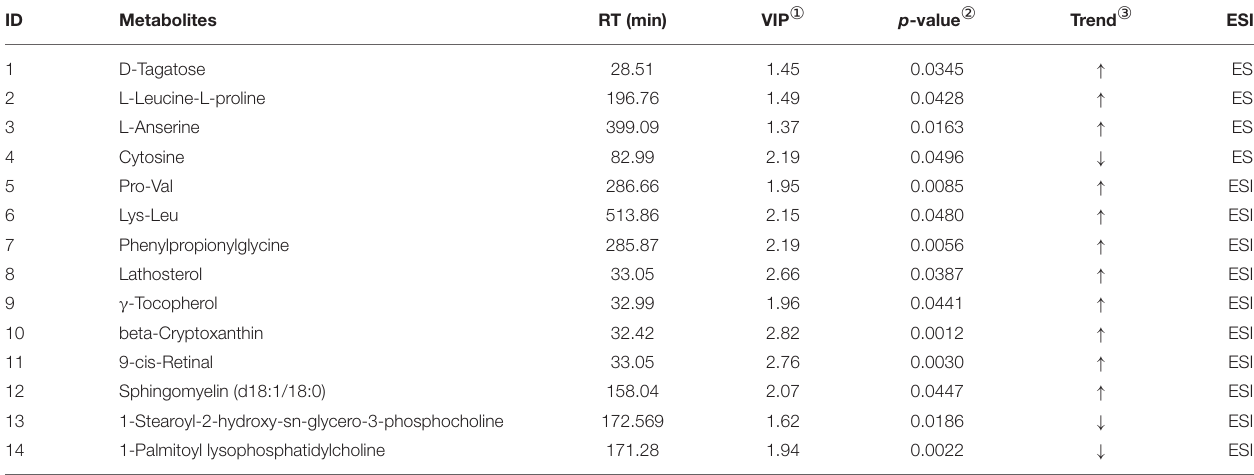
TABLE 3 | Differential metabolites in the serum of inactive ovaries and estrus groups.